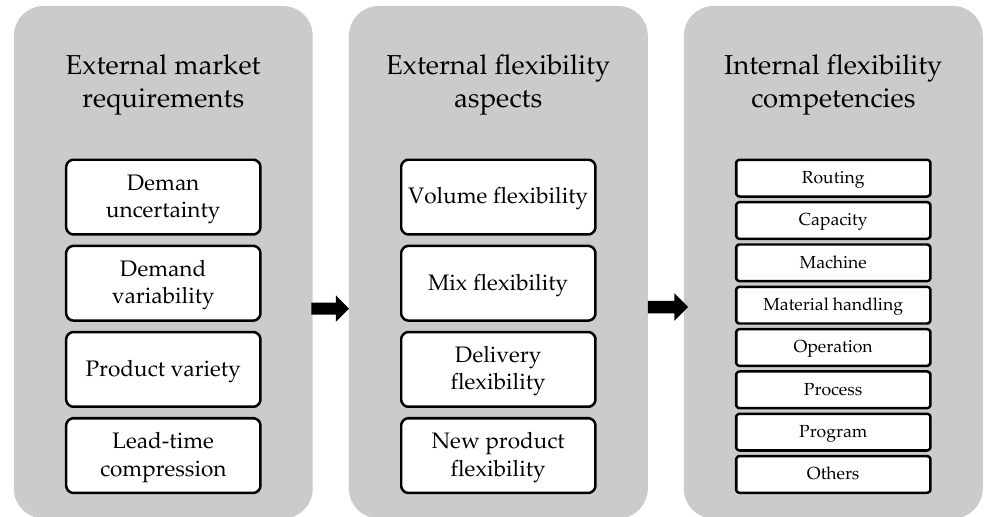
Figure 1. The link between external market requirements, external flexibility and internal flexibility (inspired by Reichhart and Holweg [26]).